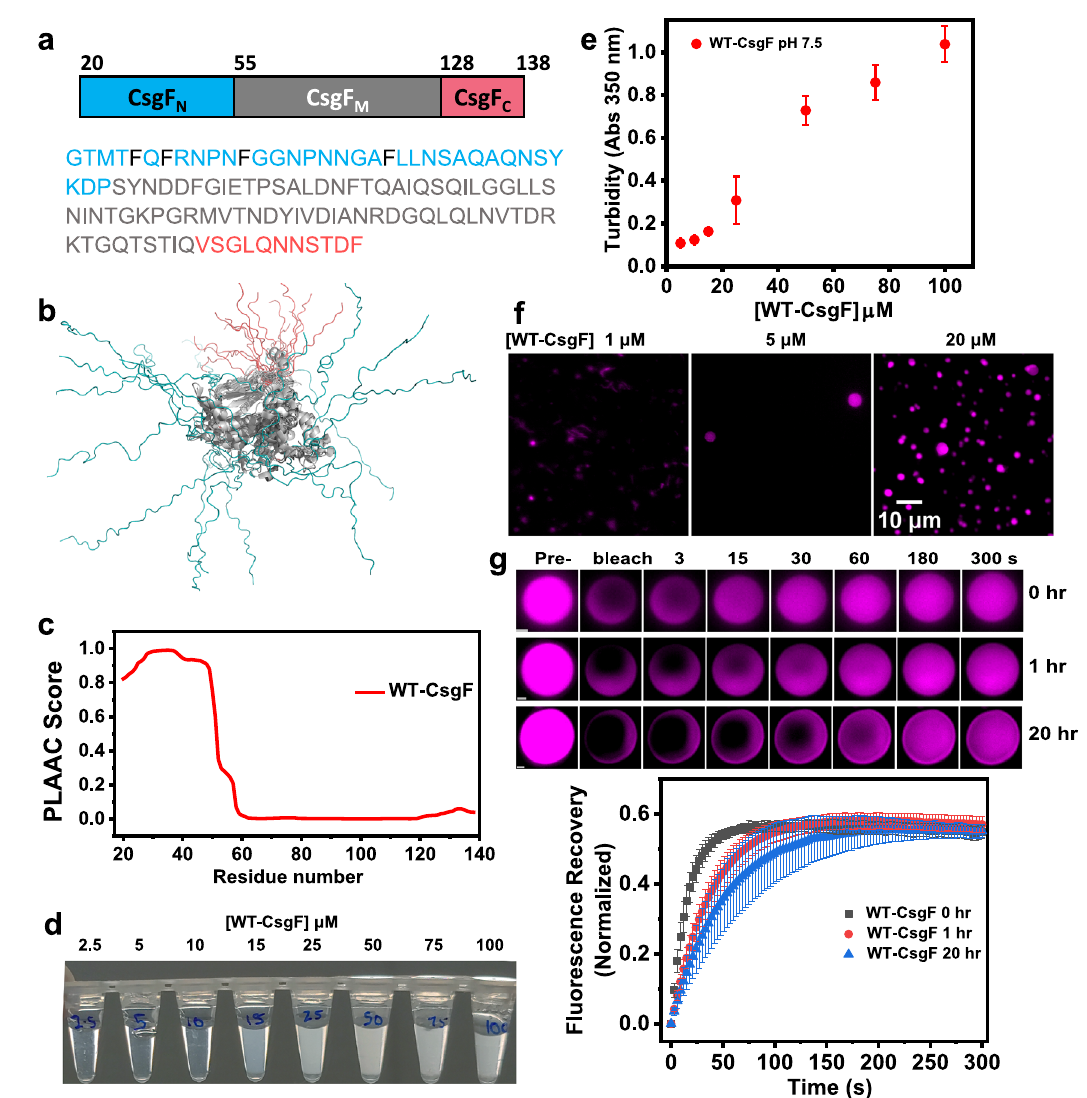
Fig. 1 | CsgF undergoes phase separation. a Schematicrepresentationand amino acidsequenceofmatureCsgF(CsgFwithoutsignalpeptide).TheN-terminalregion (amino acids 20 – 54) is colored in blue, the middle domain (amino acids 55 – 127) is showningray,andtheC-terminalregion(aminoacids128 – 138)isindicatedinpink. Phenylalanine residues in the N-terminus are indicated in black. b An overlay of 16 conformationsofWT-CsgFNMRstructure(PDBID:5M1U)generatedusingPyMOL. c Prion-like amino acid (PLAAC) analysis on WT-CsgF. d Concentration-dependent density change of WT-CsgF in 25mM potassium phosphate pH 7.5 buffer.